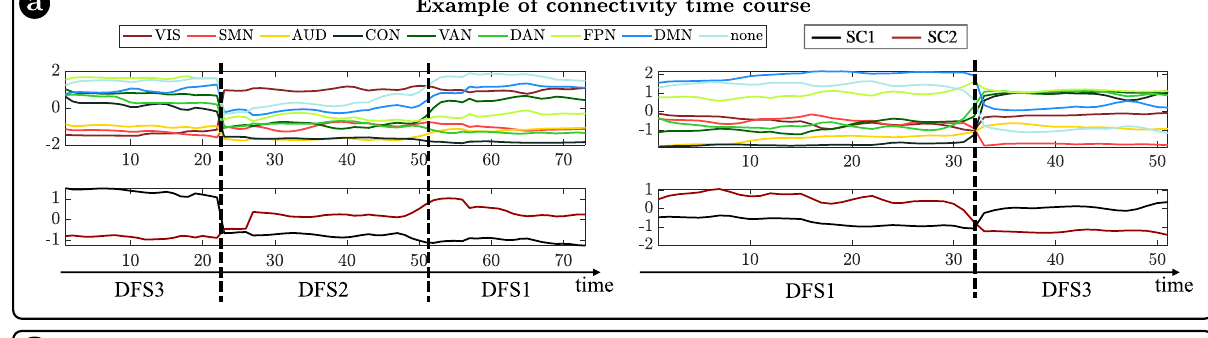
time but were less sensitive.